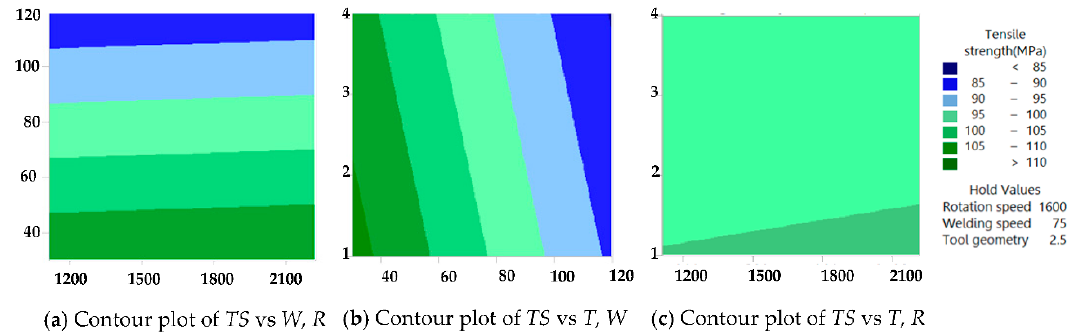
Figure 5. The contour plot of tensile strength vs. R , W , and T of the welded on FSWp of SSM 6063 aluminum alloys.